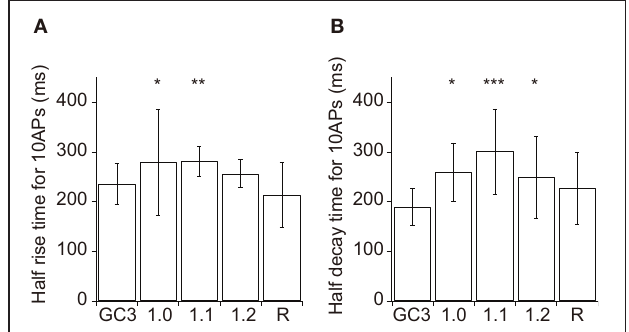
FIGURE 4 | Kinetics of GCaMP3 and GECOs in cortical layer 2/3 pyramidal cells. (A,B) The mean half rise time (A) and mean half decay time (B) of smoothed trial-averaged traces in response to 10APs at 20Hz ( n = 13 for GCaMP3, n = 9 for G-GECO1.0 and G-GECO1.2, n = 10 for G-GECO1.1, and n = 7 for R-GECO1). GEM-GECO1 was excluded from analysis due to the small number of cells showing suprathreshold responses ( n = 4). Significant difference in Dunn’s post-hoc test comparing GCaMP3-expressing cells and GECO-expressing cells: ∗ p < 0 . 05, ∗∗ p < 0 . 01, ∗∗∗ p < 0 . 001.